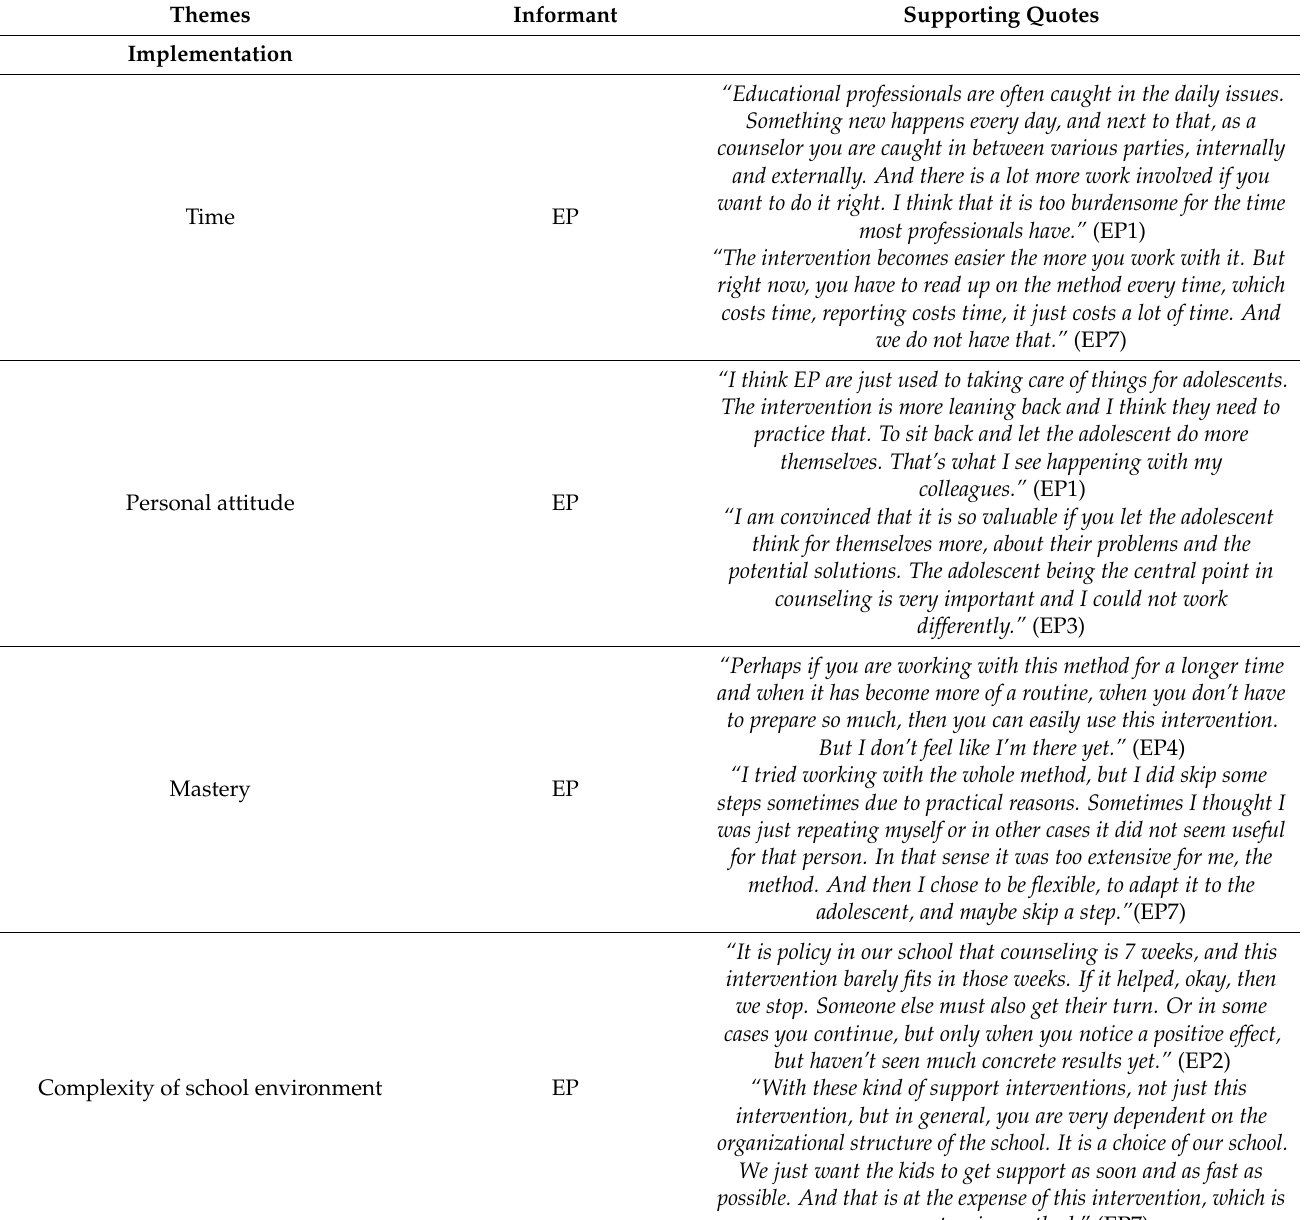
Table 5. Supporting quotes regarding implementation of the